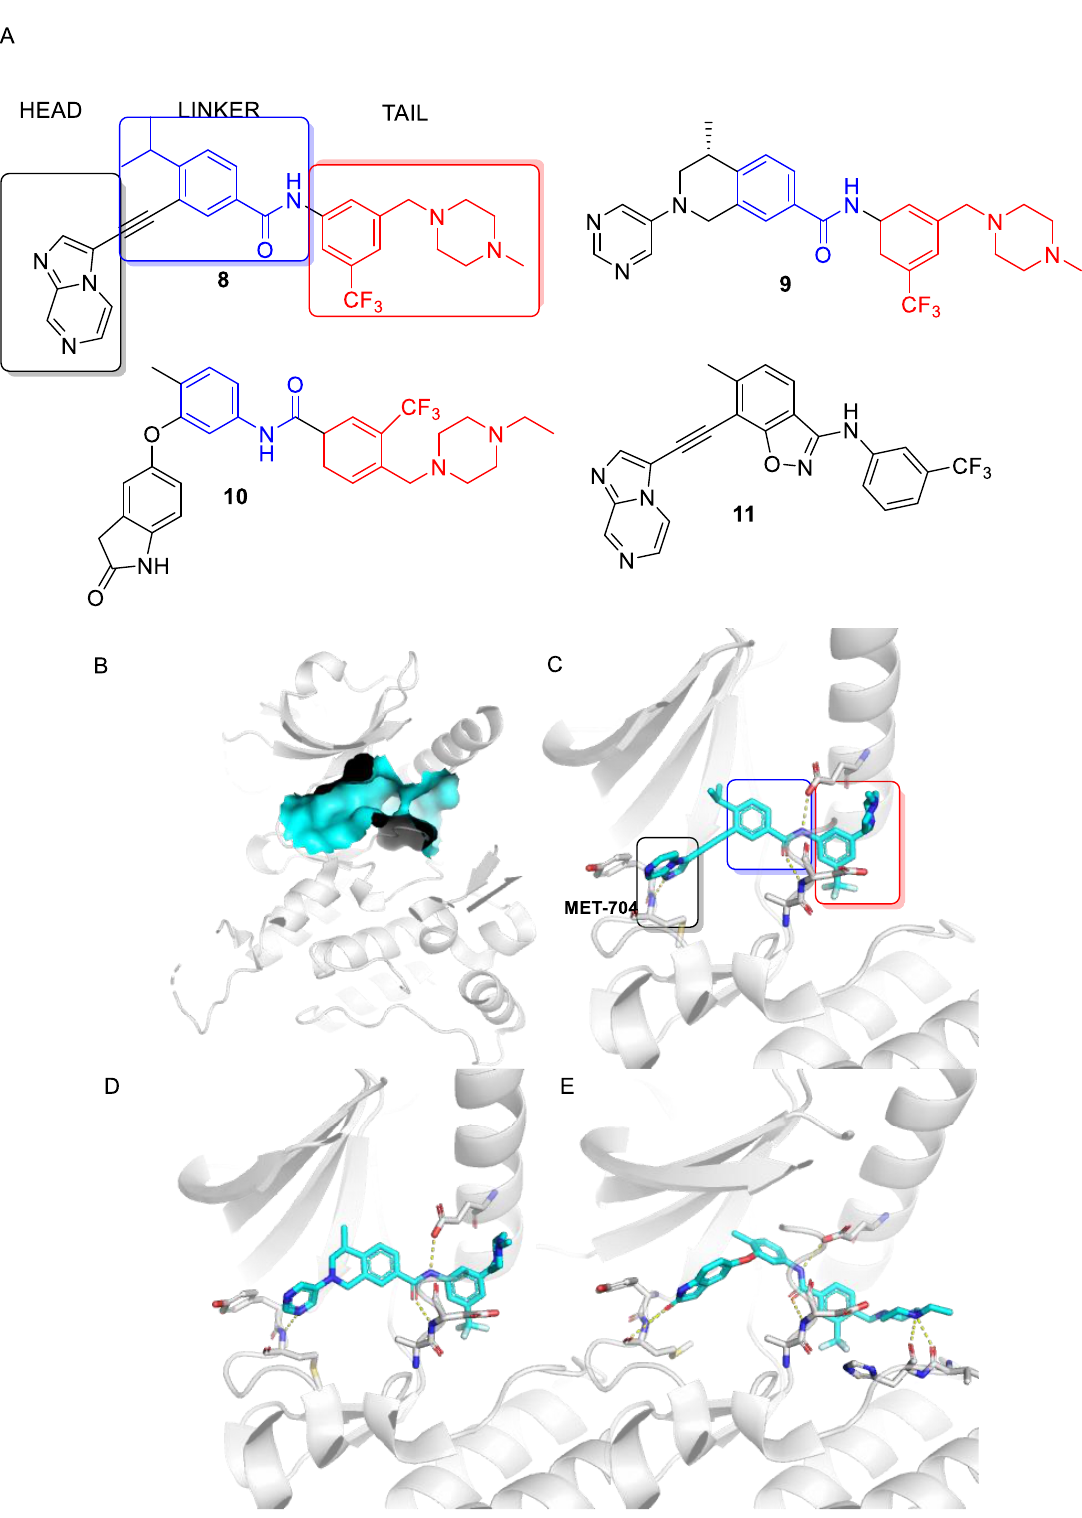
Figure 2. ( A ) DDR inhibitors can be divided into three regions based on the location in the ATP binding site. ( B ) ATP binding site location between the N- and C-terminal lobes of the kinase domain (cyan surface). ( C – E ) Binding modes for compounds 8 – 10 in the DDR1 ATP binding site (PBD codes 6GWR, 5FDP and 4CKR, respectively). The colored boxes represent the head (black), linker (blue) and tail (red) units. The hydrogen bond with Met-704 is indicated with the dashed bond. Hydrogen bonds with the side chain of Glu-672 and with the backbone amide of Asp-784 are also shown. (Images created with PyMol).